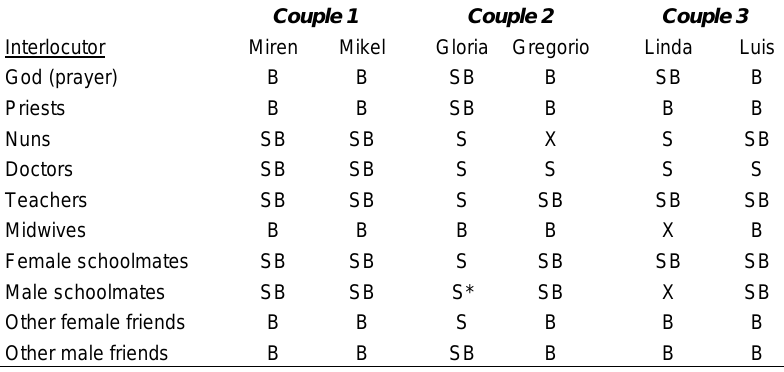
Table 2: Language Use: Social Life & Community (childhood)